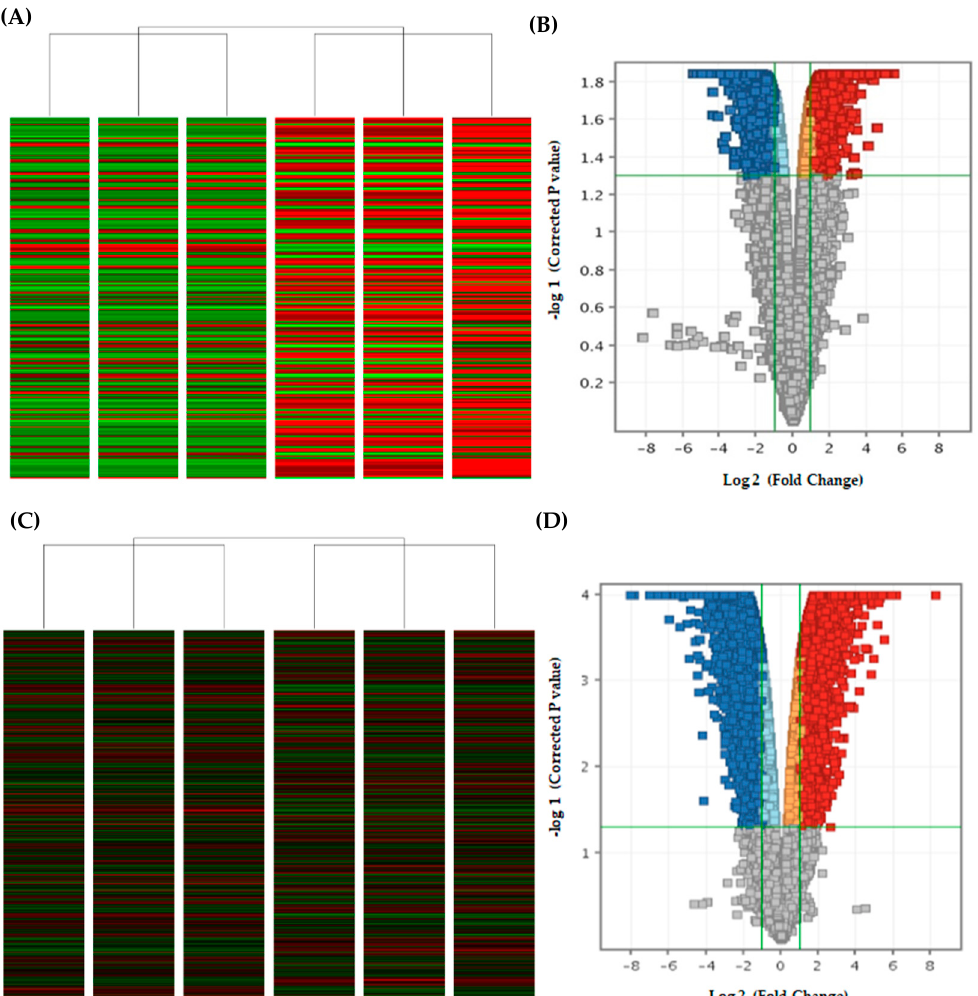
Figure 4. Images above indicate the differential expression of regulated genes in both U-2 OS and MG-63 osteosarcoma cell lines between control group and DK1 IC 50 treated group. ( A , C ) Heat maps of differential expression for both U-2 OS and MG-63 cell lines; interpret the regulated genes expression in pattern visualization form when clustering similar treatment groups together. Each grid in row represents regulated genes, while each column served as treatment group samples. ( B , D ) Volcano plots of differential expression of regulated mRNA for both U-2 OS and MG-63 with p < 0.05 and fold change ≥ 2 as well as ≤ − 2. Blue color (down-regulated) indicates that the regulated genes have p < 0.05 with ≤ − 2 fold changes. While Red color (up-regulated) indicates that the expression of regulated genes have p < 0.05 with fold changes ≥